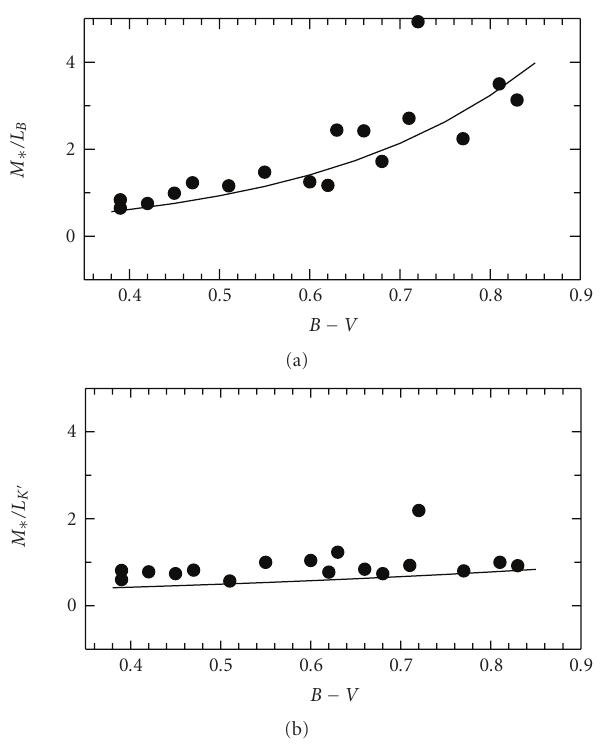
Figure 5: Inferred mass-to-light ratios for the UMa spirals in the B-band (a) and the K’-band (b) plotted against B-V colors [5]. The solid lines show predictions from populations synthesis models [16].